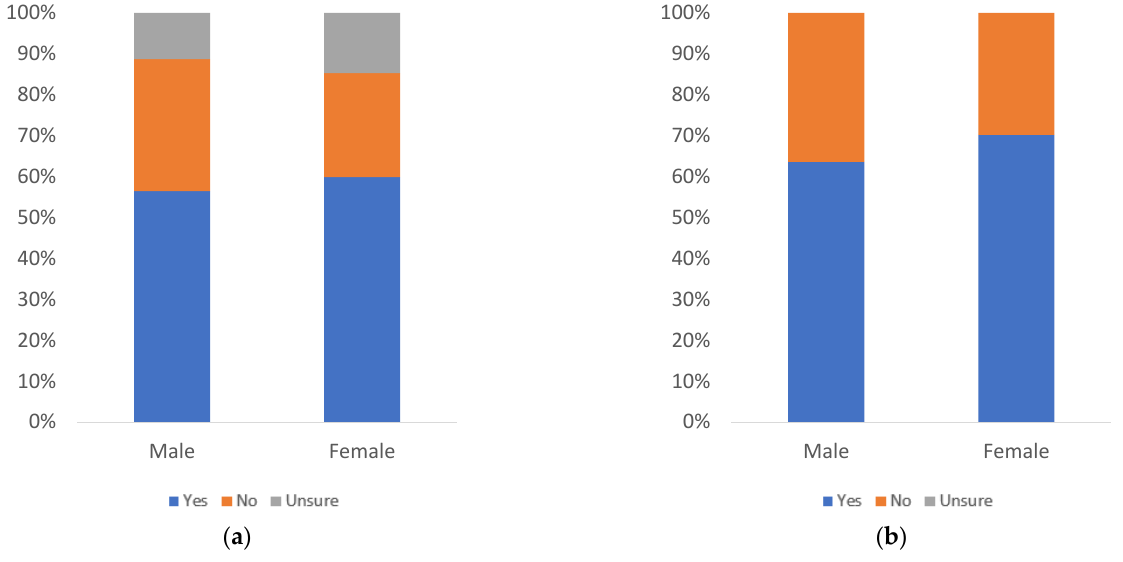
Figure 23. Label helpfulness, by gender: ( a ) with uncertain respondents (left) and ( b ) without uncertain respondents (right).